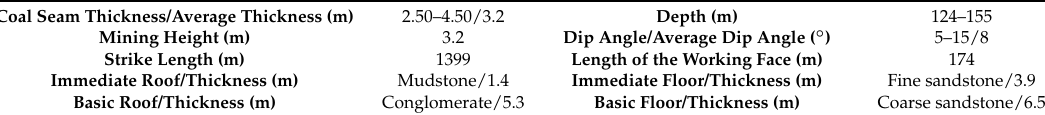
Table 2. Basic parameters of the W1-106 working face in the Yuanlin Coal Mine.